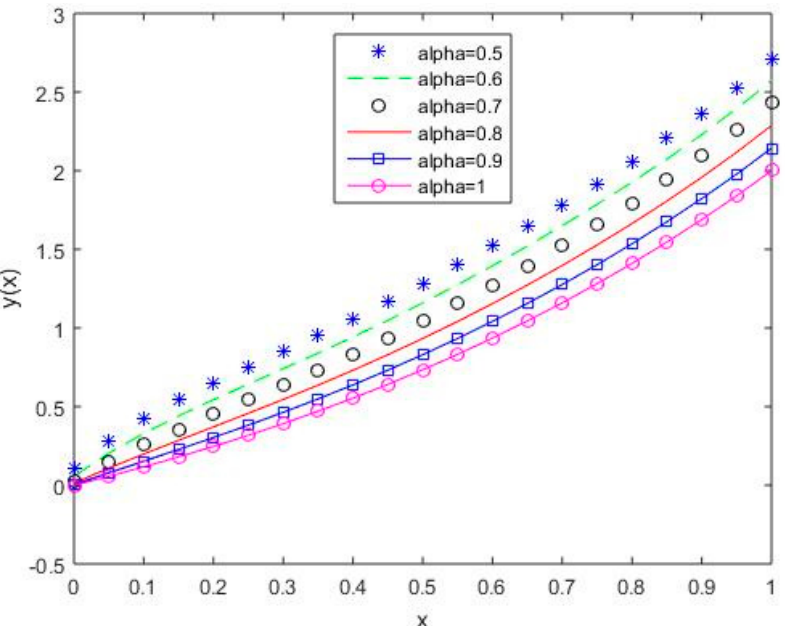
Figure 16. The behavior of solutions using S1 for 𝛼 values of 0.5, 0.6,0.7, 0.8, 0.9, and 1 , Example 2.